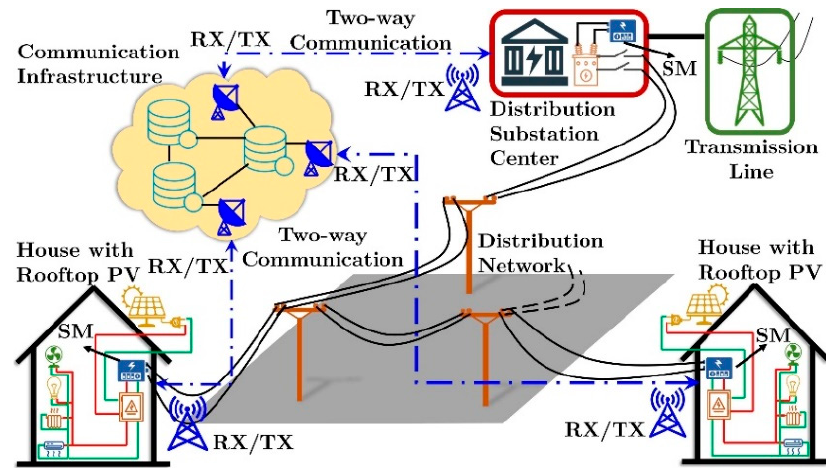
Figure 1. Effective use of smart meters in microgrids with DERs [65].